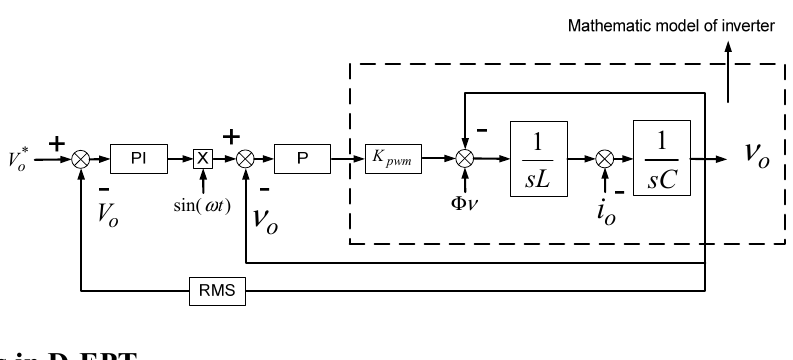
Figure 3. The output stage control strategy.